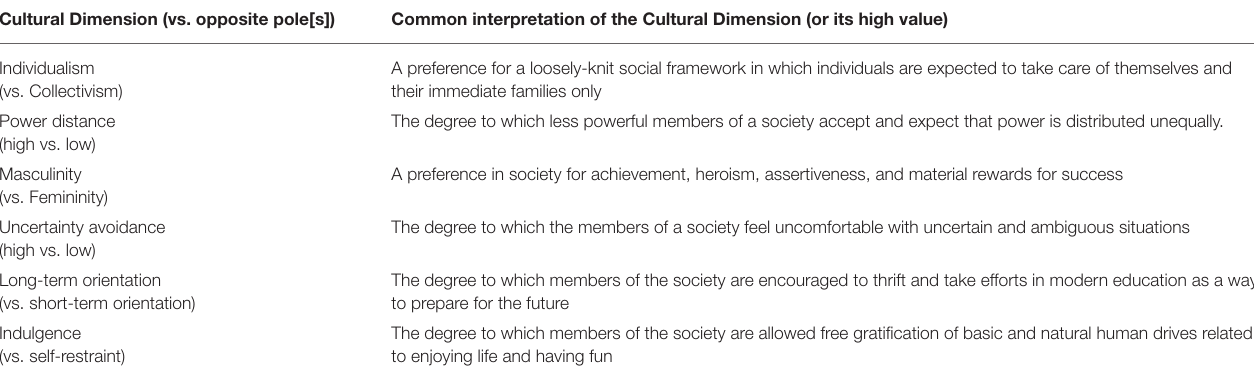
TABLE 1 | The framework of cultural dimensions and their common interpretation (Hofstede, 1980, 2001; Minkov and Hofstede, 2010). Cultural Dimension (vs. opposite pole[s]) Common interpretation of the Cultural Dimension (or its high value) Individualism (vs.